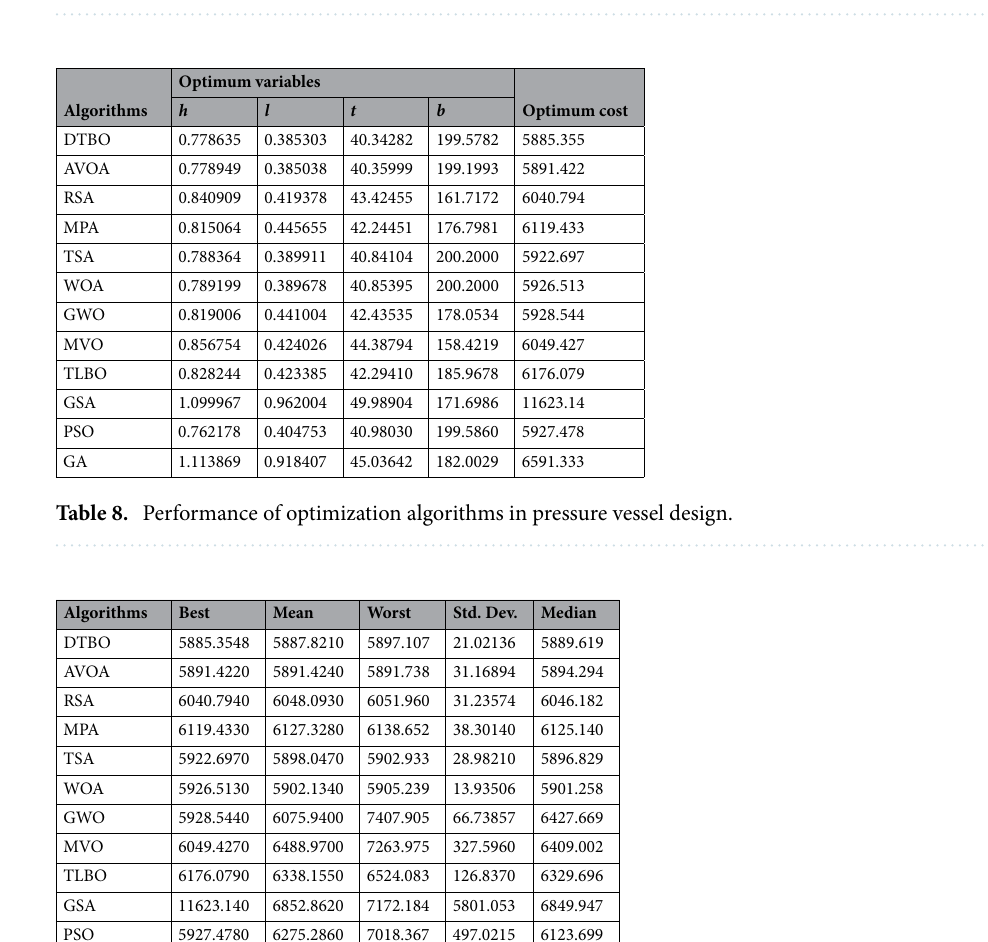
Table 7. p values from Wilcoxon sum rank test.